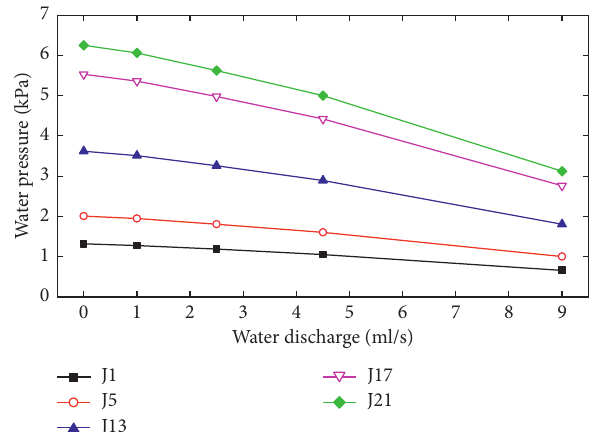
Figure 19: Relationship between the water pressure outside the lining and the water